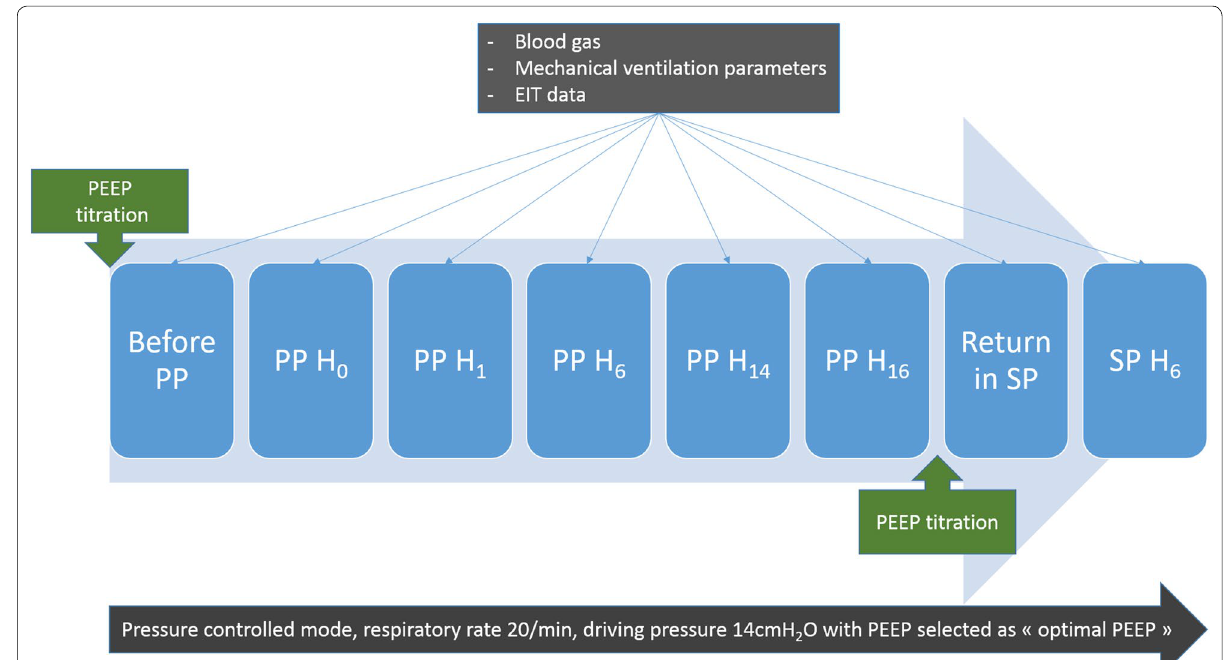
Fig. 1 Study protocol. EIT electrical impedance tomography, PEEP positive end‑expiratory pressure, PP prone positioning, PP H 0 immediately after prone positioning, SP supine